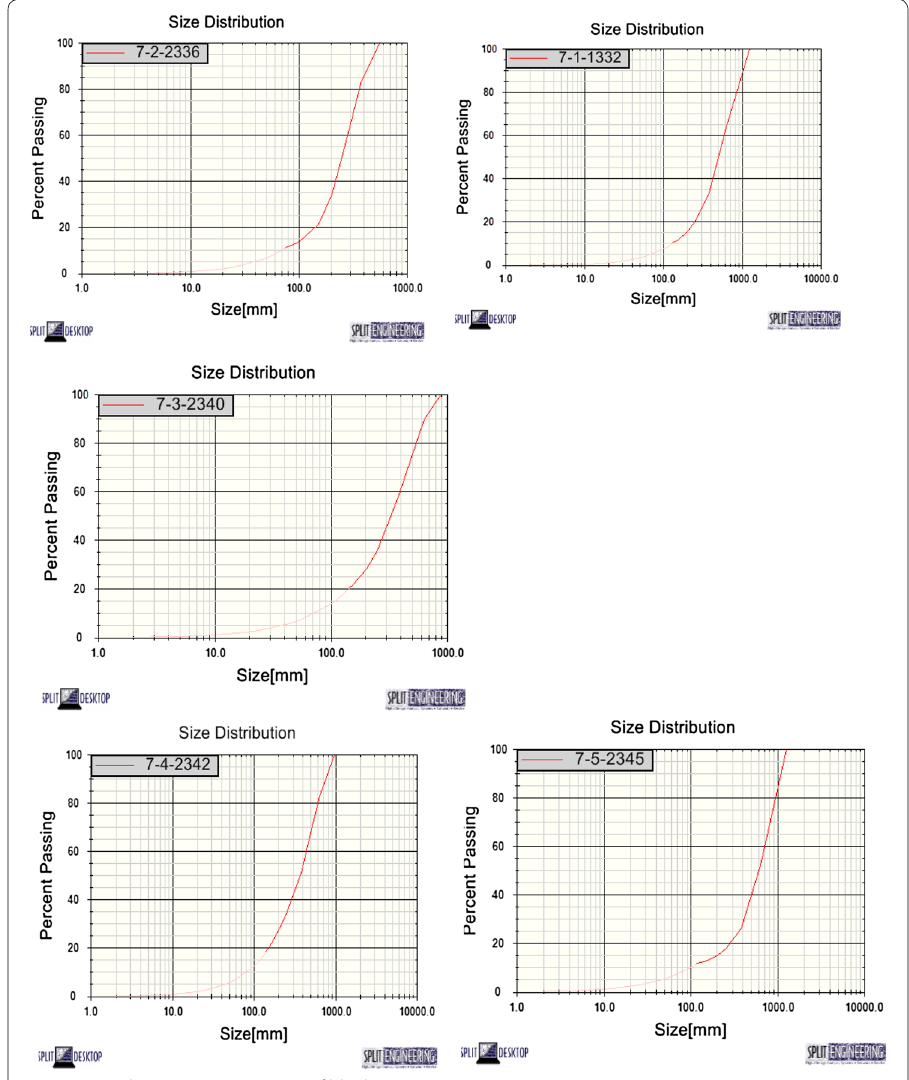
Fig. 2 Cumulative grain-size curves of block no.